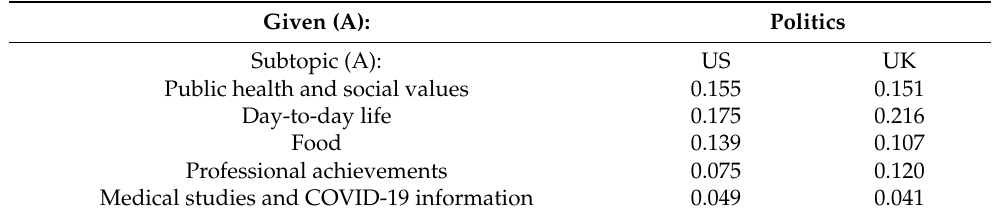
Table 3. The conditional probability of a tweet belonging to a topic given that it belongs to the topic of politics.